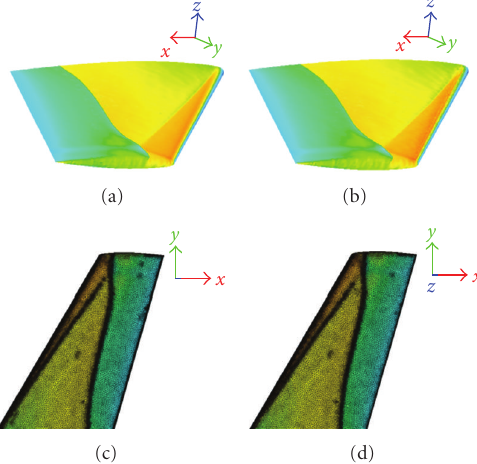
Figure 28: Solution ( M ∞ ) and grids after a second adaptation step on the ONERA M6 wing with (left) and without (right)